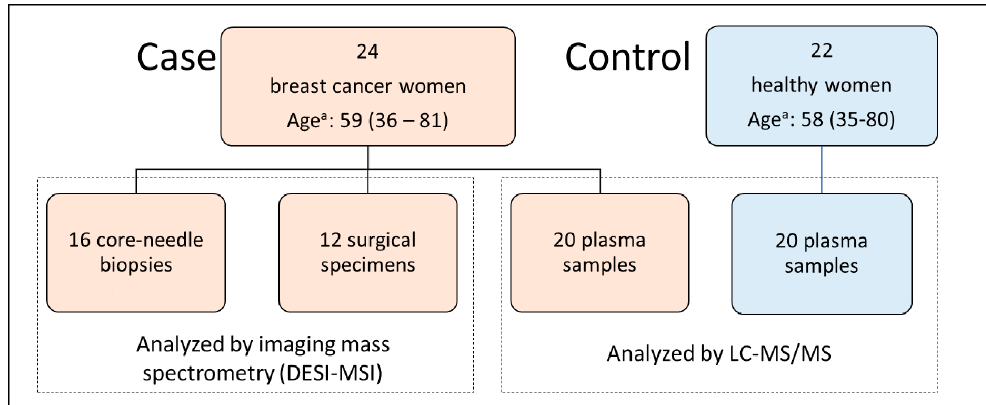
Figure 5. Distribution of samples over case and control groups and the technique of choice employed in each subset: Desorption-Electrospray-Ionization—Mass Spectrometry Imaging (DESI-MSI) for tissue samples and Liquid Chromatography-Tandem Mass Spectrometry (LC-MS / MS) for plasma samples. a Age is expressed as medium age (range).